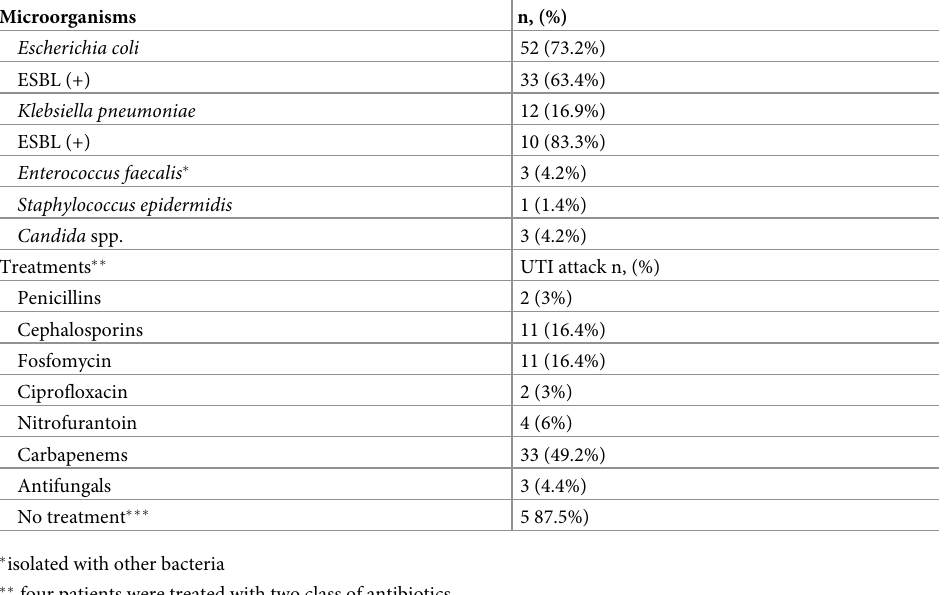
Table 3. Causative agents and treatment choices for UTI during the first year of transplantation (71 agents in total 67 UTI